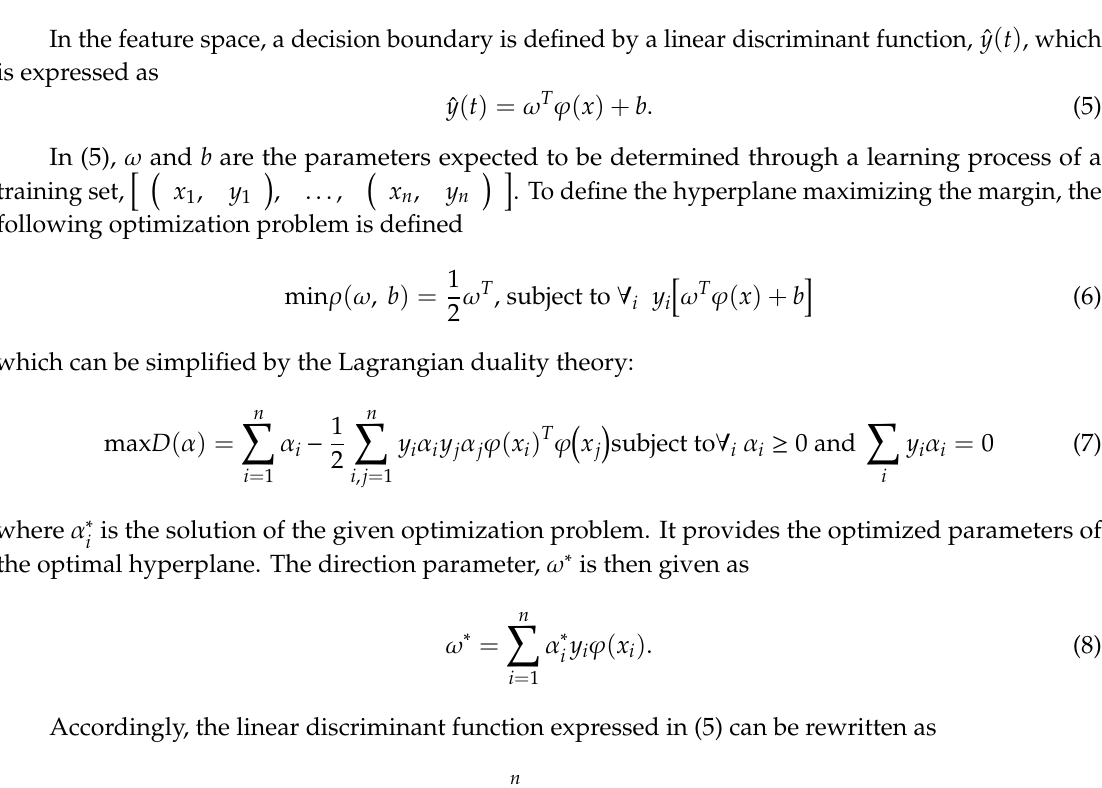
Figure 3. Illustration of optimal separating hyperplanes.